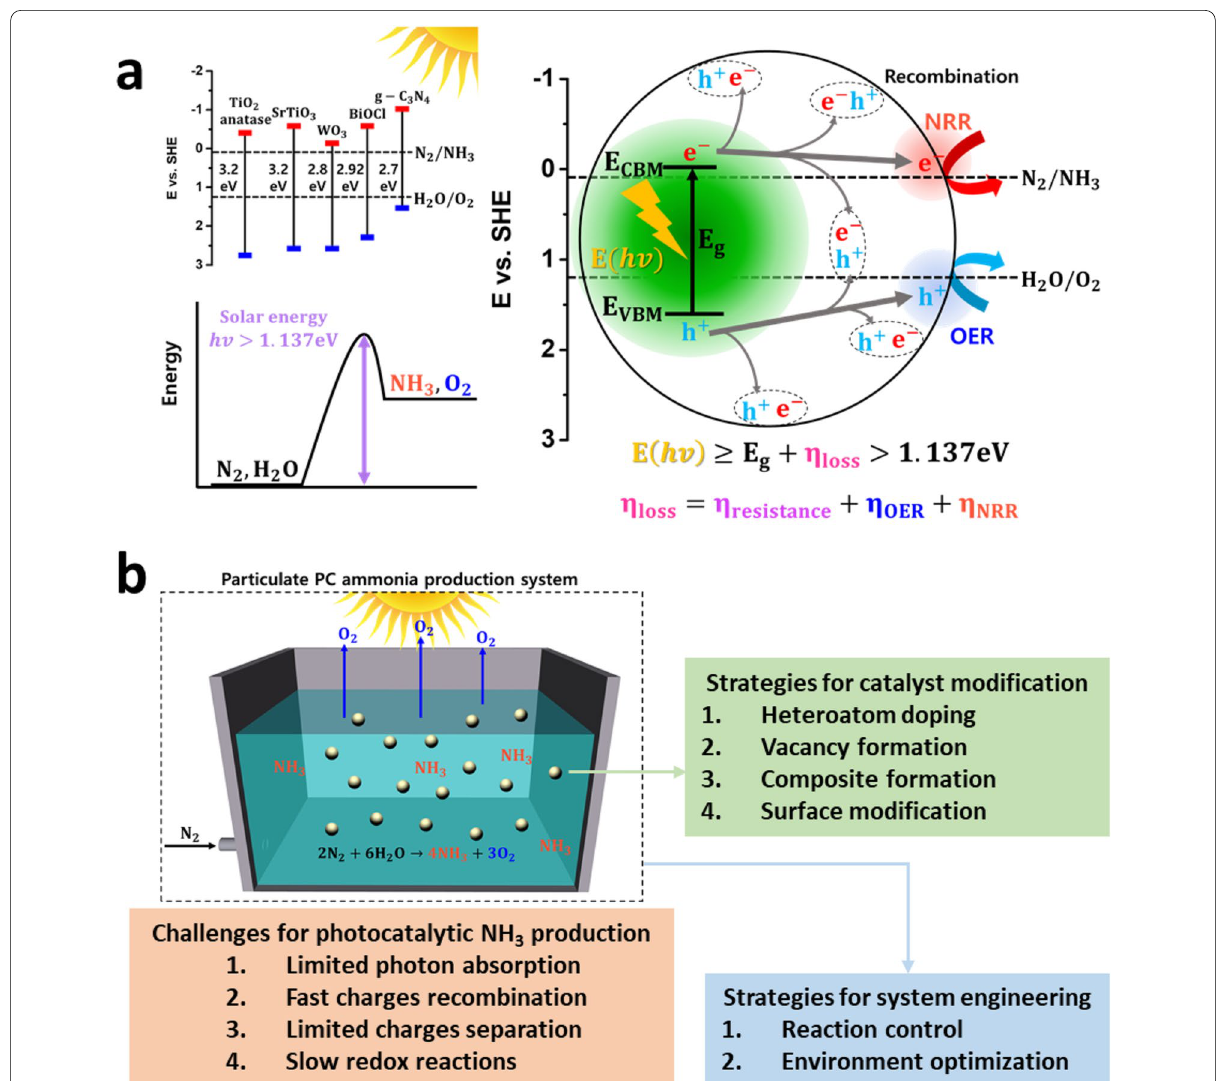
Fig. 1 a The schematic illustration of photochemical nitrogen reduction reaction [15]. b The challenges and strategies for photocatalytic NH 3 production in particulate photocatalytic (PC) ammonia production